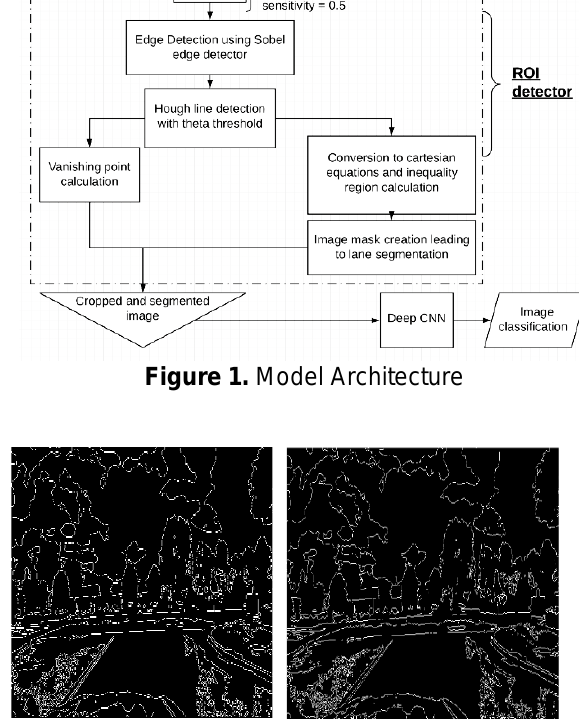
Figure 2. Sobel (left) vs Canny (right) edge detectors